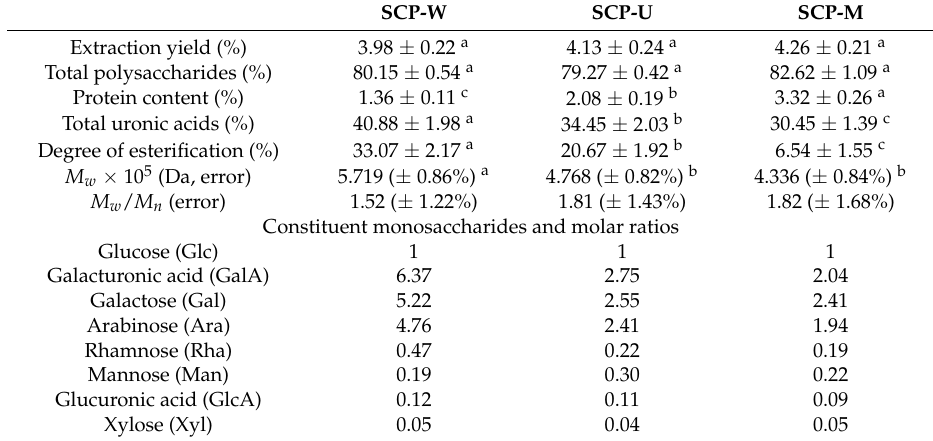
Table 3. The chemical composition, molecular weights ( M w ), polydispersity ( M w / M n ), and constituent monosaccharides of SCP-W, SCP-U, and